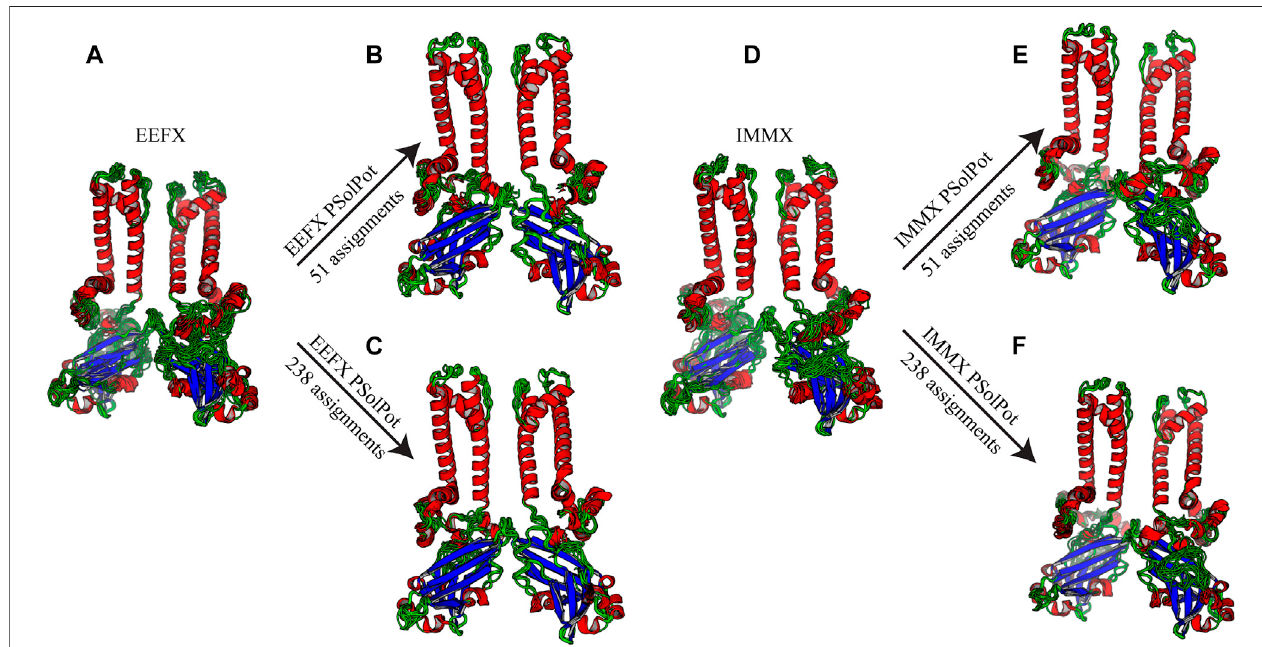
FIGURE3| Ensemble often loweststructure in each stepofcalculation (A) Nowater-edited restraints withEEFxpotential term, (B) 51unambiguous water-edited restraints withEEFxpotential, (C) 238ambiguousandunambiguouswater-editedrestraintswithEEFxpotentialterm, (D) Nowater-editedrestraintswithIMMxpotential term, (E) 51 unambiguous water-edited restraints with IMMx potential term, (F) 238 ambiguous and unambiguous water-edited restraints with IMMx potential term.